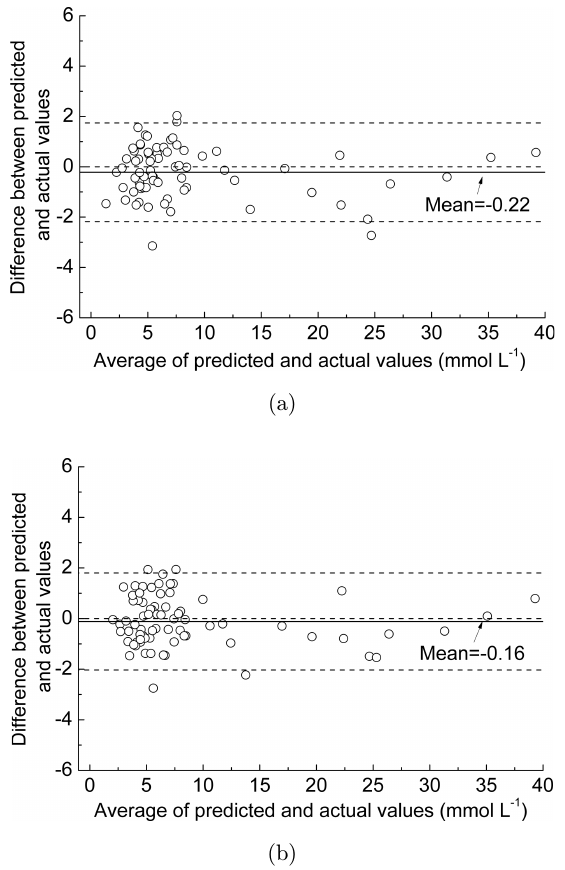
Fig. 7. BA analysis between the predicted and actual SUN values based on the optimal models for (a) EC-PLS and (b)